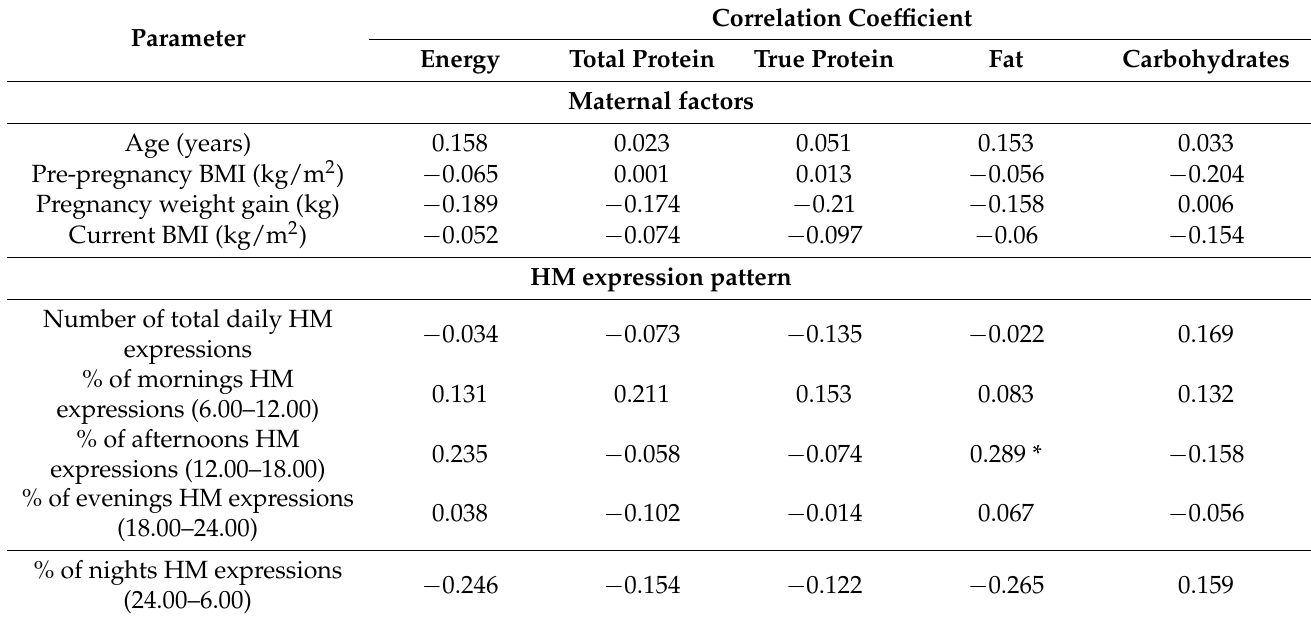
Table 5. Correlations 1 between maternal factors, HM expression pattern and DHM composition in the end of milk donation to